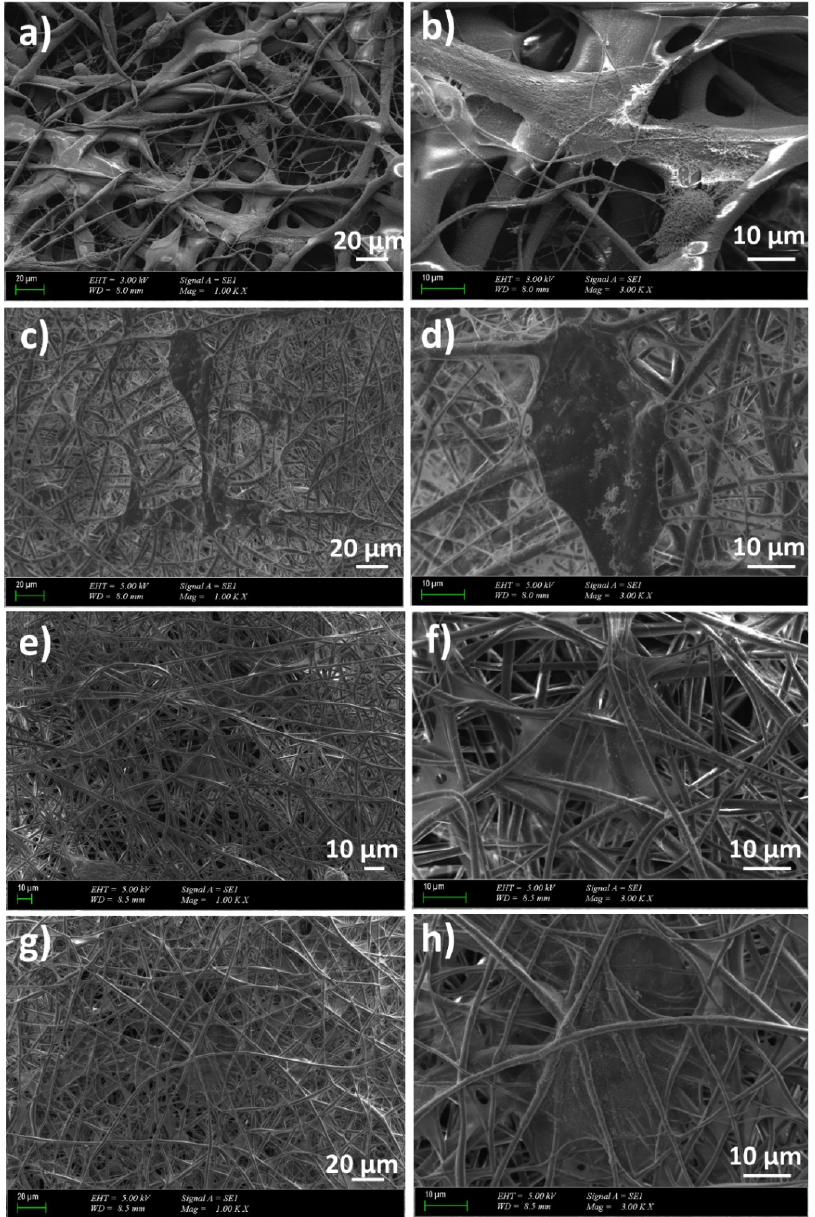
Figure 8. The fibroblast cell morphology on the scaffolds: PLA ( w / v ) ( a , b ), PLA ( w / v )/10 J ( c , d ), PLA ( w / v )/20 J ( e , f ), PLA ( w / v )/30 J ( g , h ).